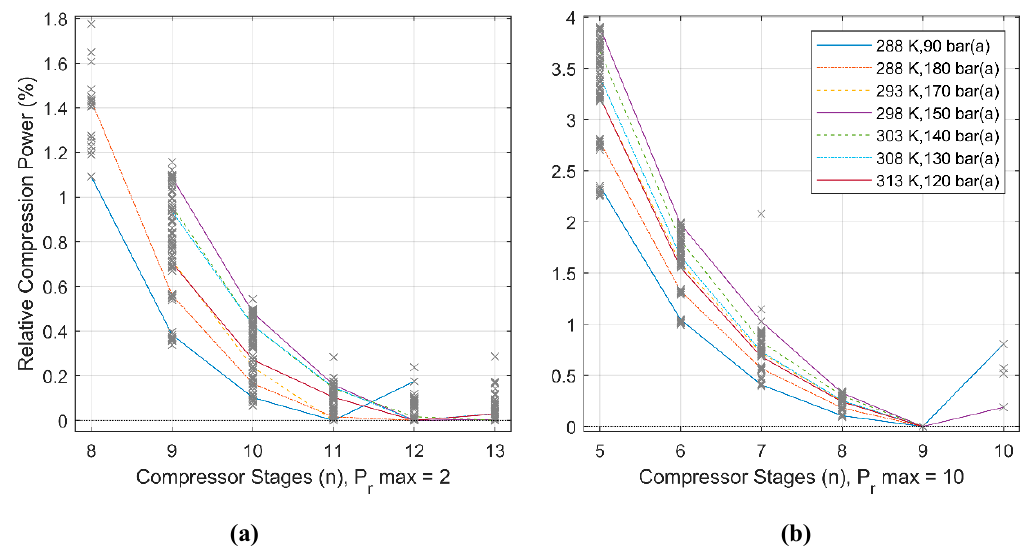
Figure 4. Relative energy consumption vs. stages for post-combustion capture, ( a ) constrained cases and ( b ) unconstrained cases (right).